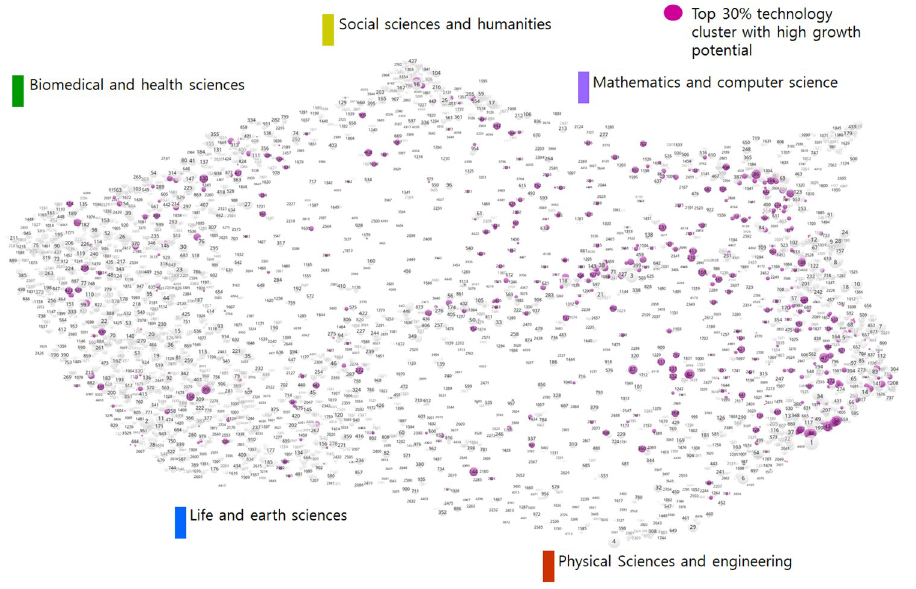
Fig 8. Technology clusters with high growth potential (purple